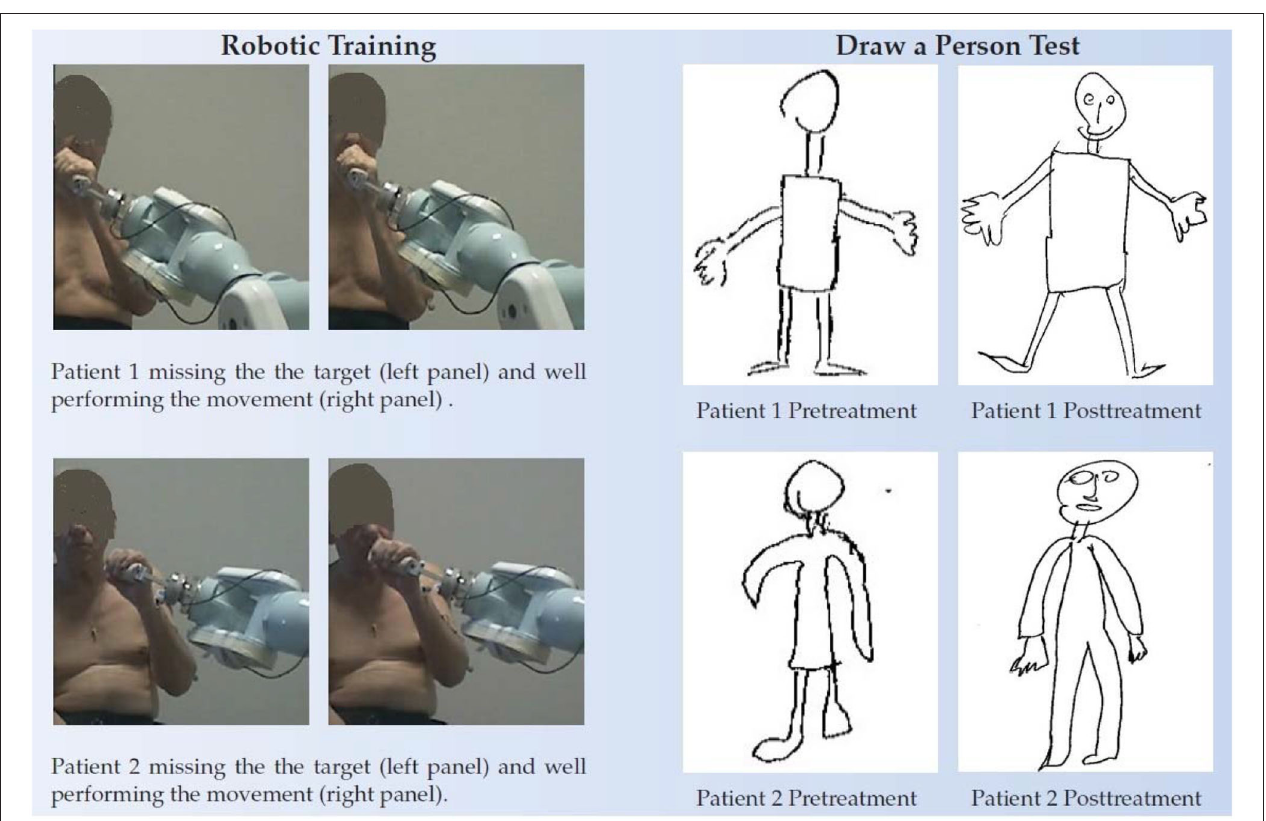
FIGURE 5 | Draw-A-Person test of two chronic patients. Left panel, the two patients performing the robot assisted movements (first trials very left pictures) and after some sessions of training. In the beginning, they were not able to place the robot handle in front of the mouth as requested. Right panel, the pre and posttreatment Draw-A-Person